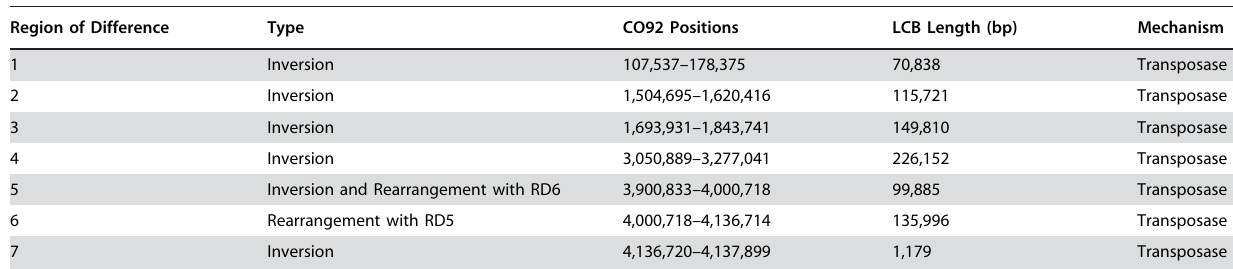
Table 1. Characteristics of the six inversions and one large rearranged LCB found via MAUVE. .. ... .... ... ... .... ... ... .... ... ... .... ... ... .... ... ... .... ... ... .... ... ... .... ... ... .... ... ... .... ... ... .... ... ... .... ... ... .... ... ... .... ... ... . Region of Difference